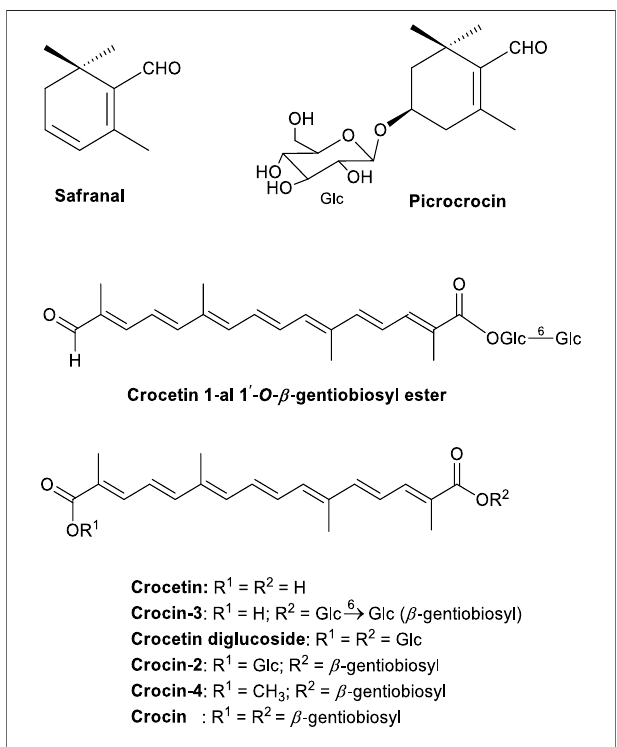
FIGURE 2 | The major saffron phytochemical